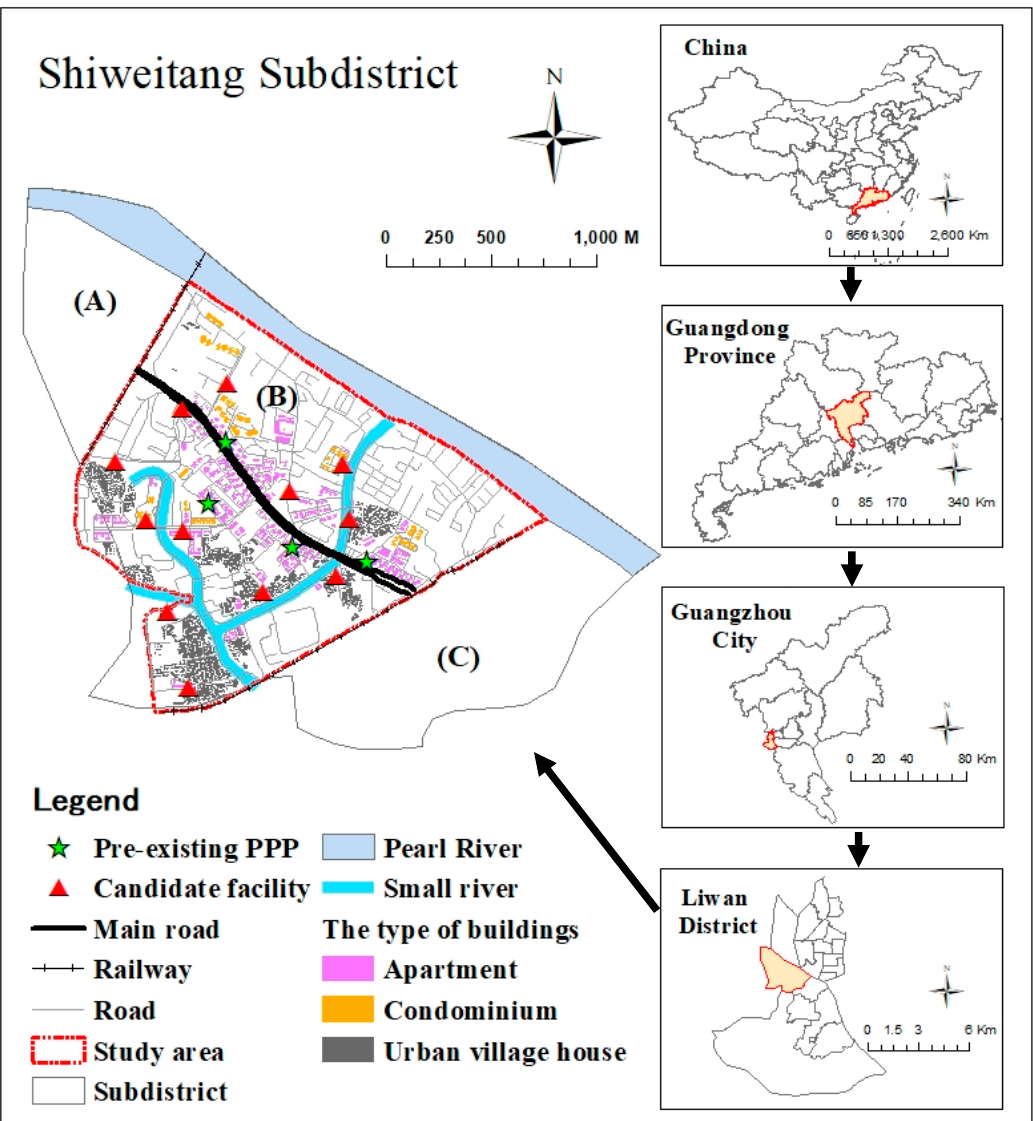
Figure 1. Study area; locations of environmental components and pre-existing and candidate PPP facilities.